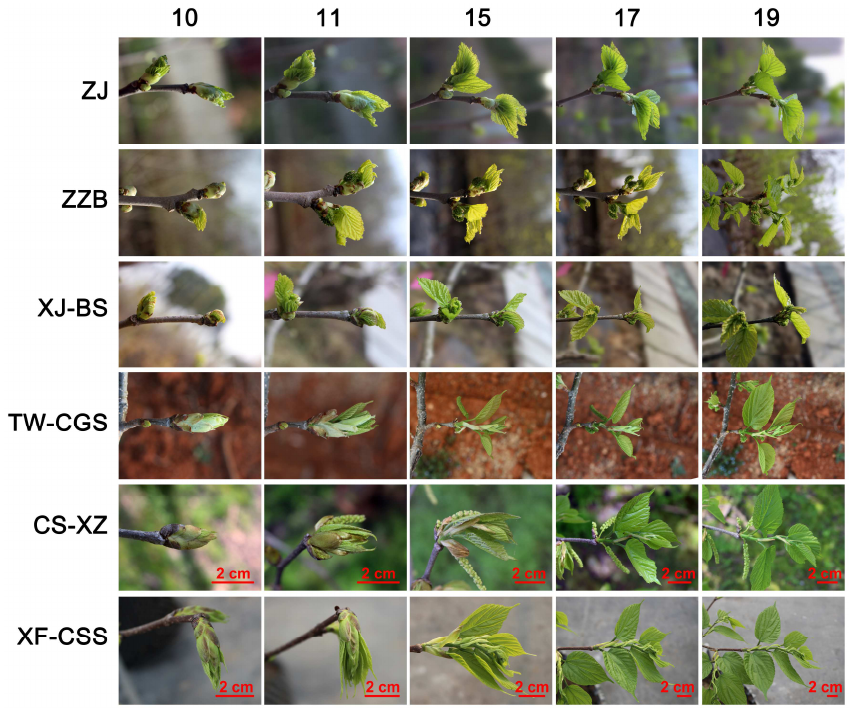
Figure 2. Stages of leaf development for mulberry according to the BBCH scale. Buds are densely covered with hairs in CS-XZ.